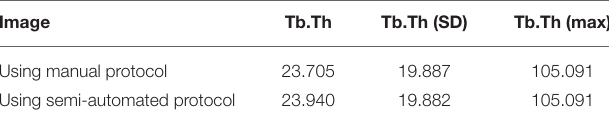
TABLE 5 | Tb.Th measurement with and without downsizing option (in µ m).